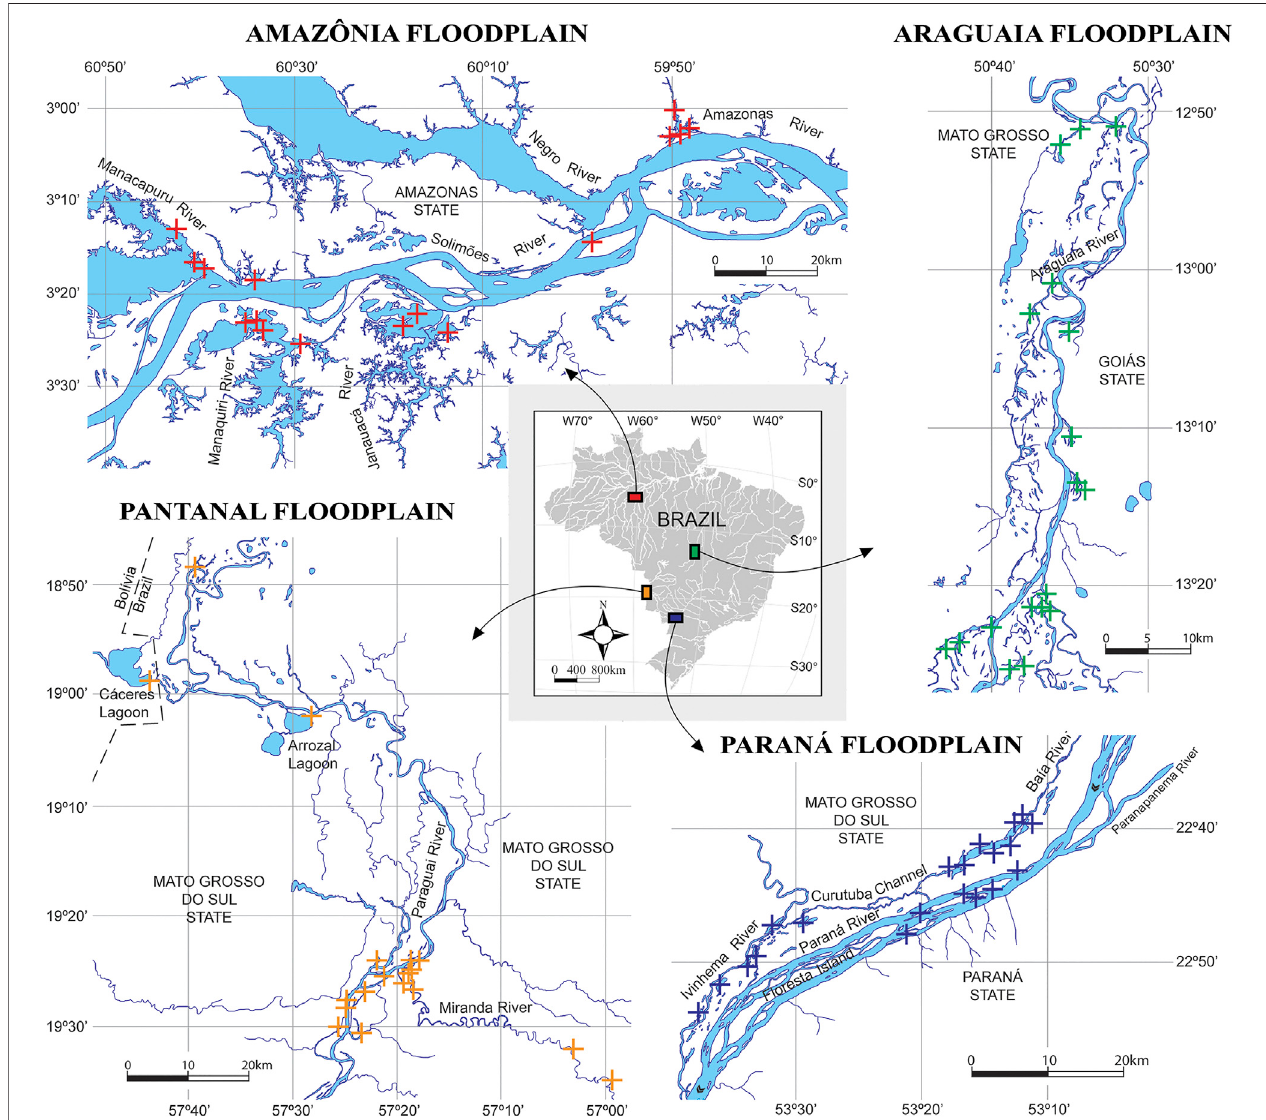
FIGURE1| Mapofthestudyareashowingthesurveyed freshwater lakesfrom theAmazônia(redsymbols),Araguaia(green symbols),Pantanal (orange symbols), and Paraná (blue symbols) fl oodplains.